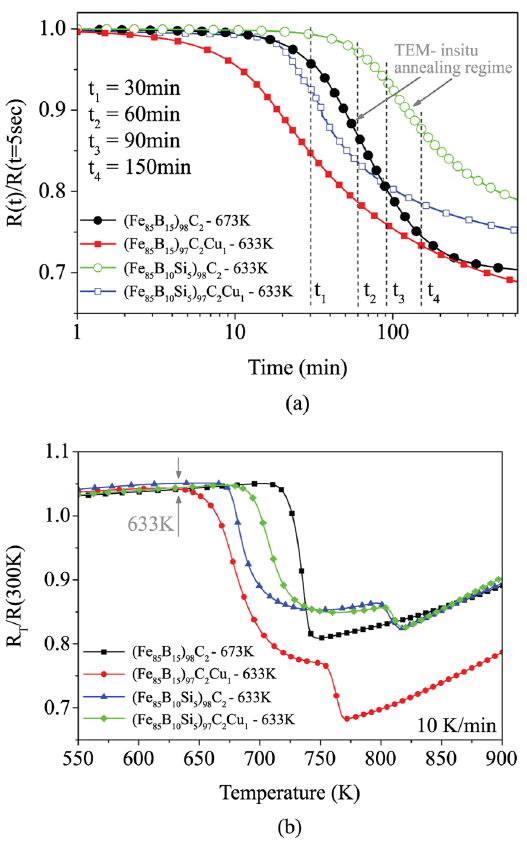
Figure 3. (a) Temperature dependence of the relative electrical resistivity for the systems with different chemical composition, marked - the temperature chosen for isothermal annealing for XRD analysis. (b) Evolution of relative electrical resistivity for the studied systems during isothermal annealing at 633 K and 673 K (t